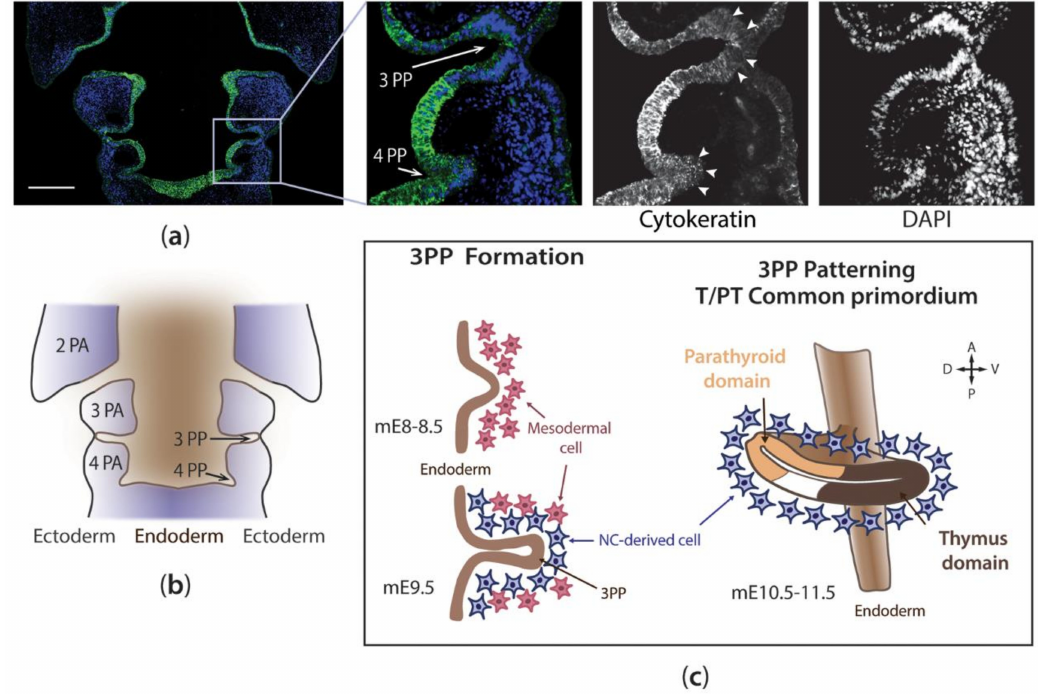
Figure 2. The early stages of thymus development. Hemi-coronal section of the pharyngeal region of a chicken embryo immunodetected with cytokeratin antibody (clone AE1 / AE3, which binds to cytokeratin 1–8, 10, 14–16, and 19), at E4, a stage prior to Foxn1 expression. Cytokeratin-positive endoderm and ectoderm cells are observed. The columnar epithelium of the pouches is indicated by white arrowheads in the magnified images ( a ). Schematic representation of coronal section (a), detailing PP and PA locations ( b ). Schematic representation of the cellular interactions between the endoderm and surrounding mesenchymal cells during the early stages of thymus organogenesis in the mouse model ( c ). See main text for details. Color code: Endoderm-, mesoderm-, and NC-derived cells in brown, rose, and blue, respectively. A—anterior; D—dorsal; mE—embryonic day of development in the mouse; NC—neural crest; PA—pharyngeal arch; PP—pharyngeal